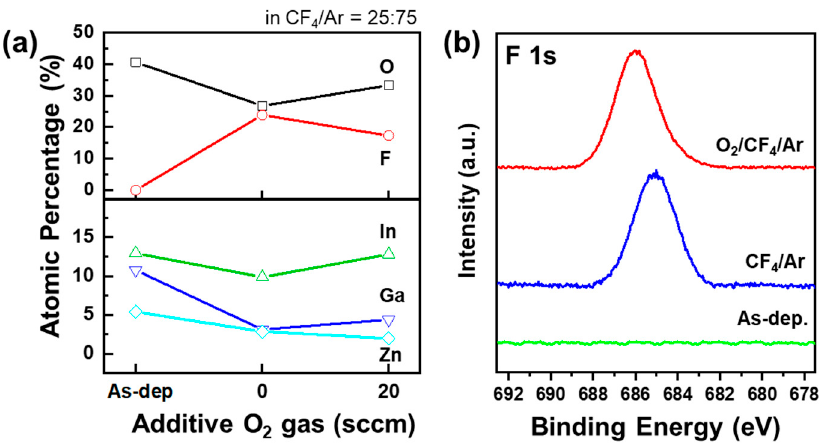
Figure 3. XPS analysis. ( a ) Chemical composition of IGZO thin film surface and ( b ) narrow spectra of F 1s peak as a function of additive O 2 gas flow rate with fixed CF 4 /Ar =25:75 sccm.